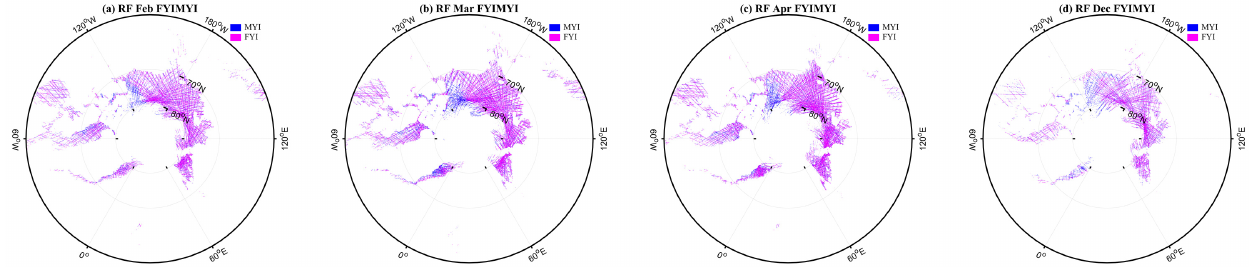
Figure A15. RF for FYI-MYI classification using the data in December as the training set. The data in ( a ) February, ( b ) March, ( c ) April, and (d) November are used as the test set in turn.